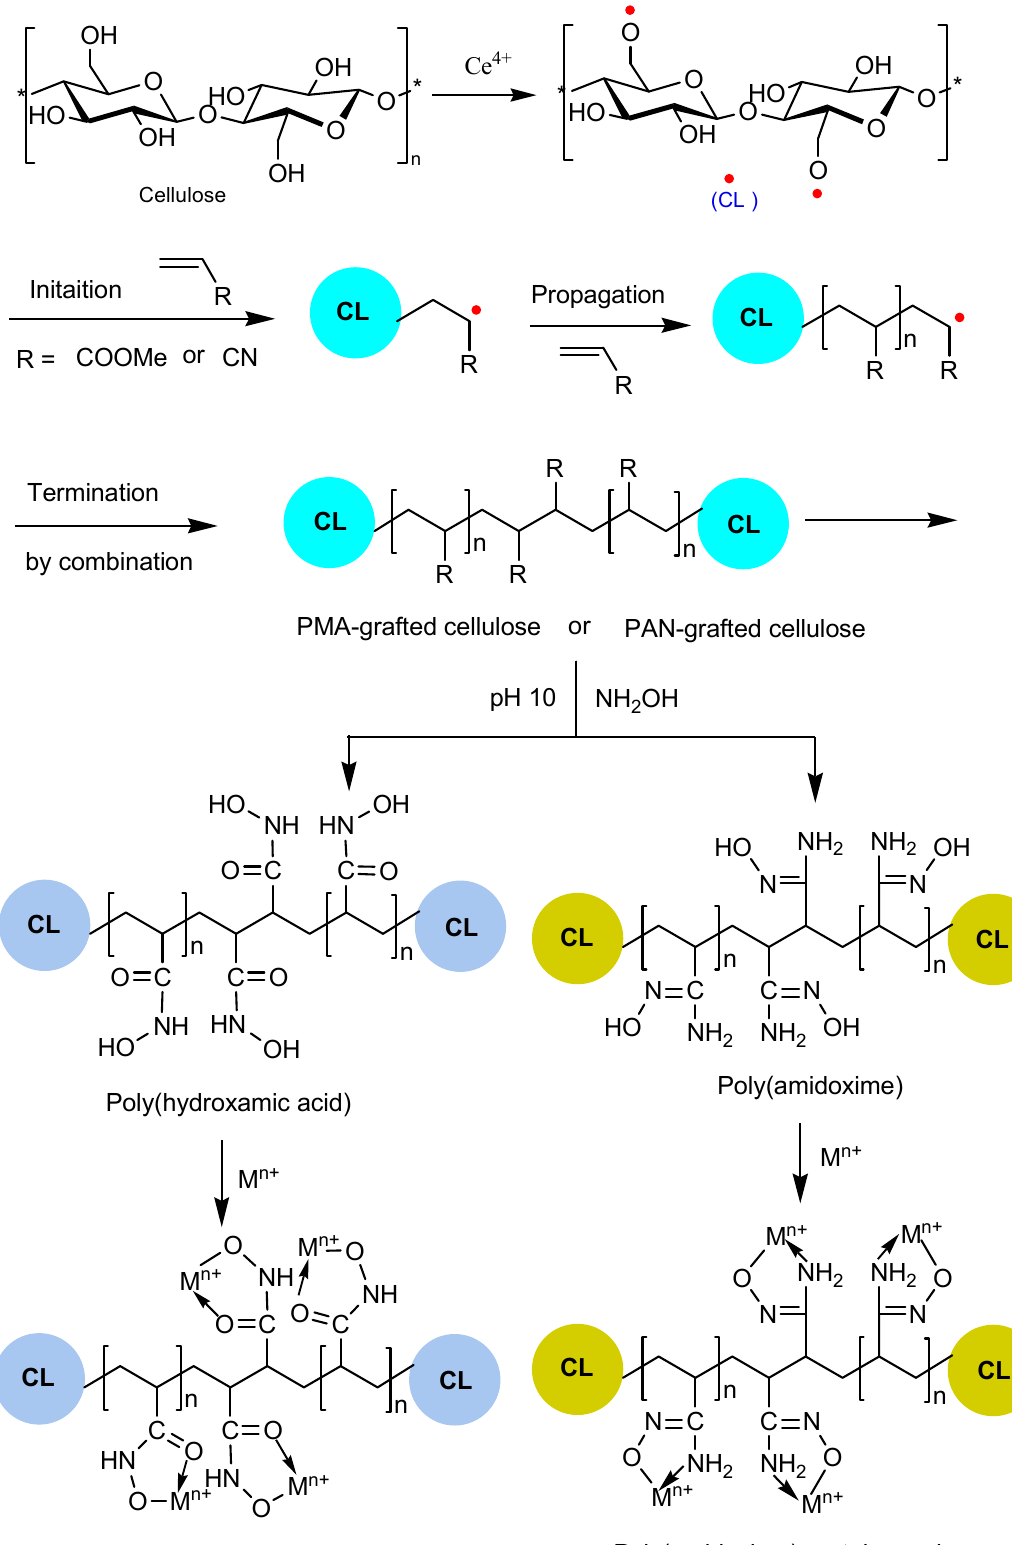
Scheme 1. PMA-grafted jute cellulose, PAN-grafted jute cellulose, poly(hydroxamic acid)